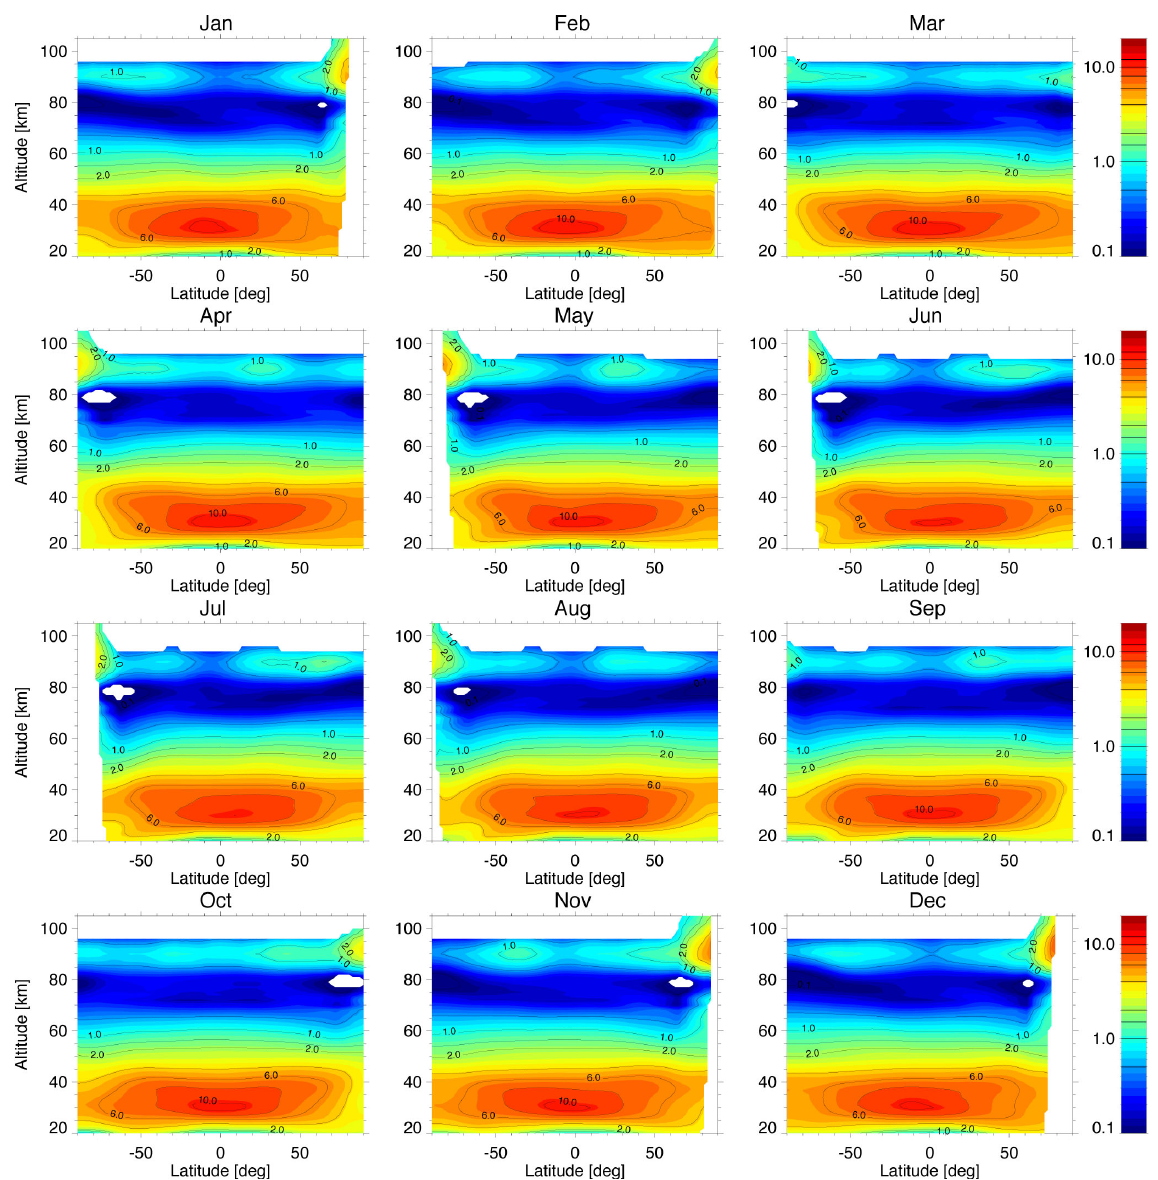
Figure 11. Composite monthly zonal mean of MIPAS data taken in the MA mode for the 2007–2012 period for daytime (local time of 10:00). White areas denote regions where MIPAS has no sensitivity to measure the very low ozone values. Contours are 0.1, 0.5, 1, 1.5, 2, 4, 6, 8, 10, and